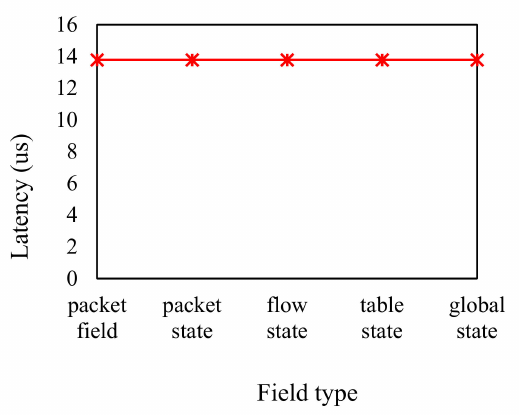
Figure 10. Time required to search for and insert various types of states into MSSA.